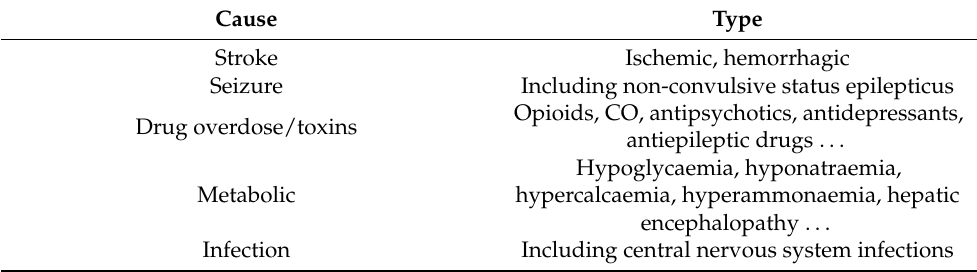
Table 2. Main causes of sudden onset coma